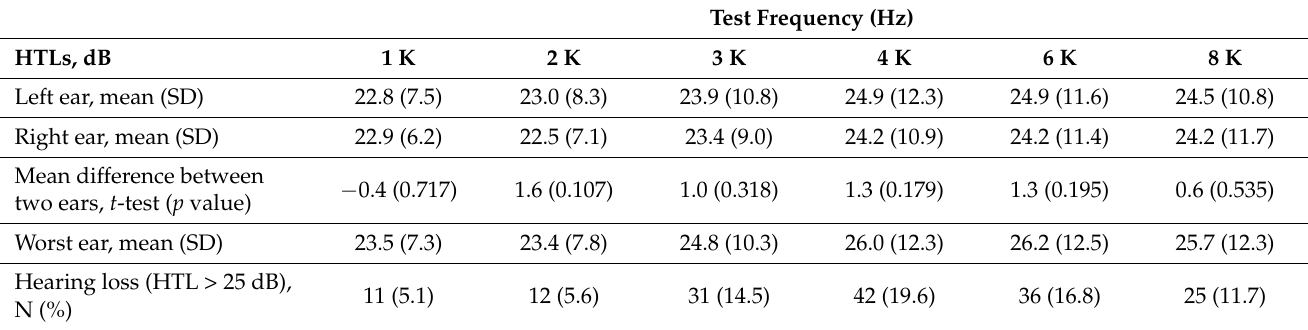
Table 4. Mean and standard deviation of HTLs and prevalence of hearing loss at all test frequencies (N = 214).